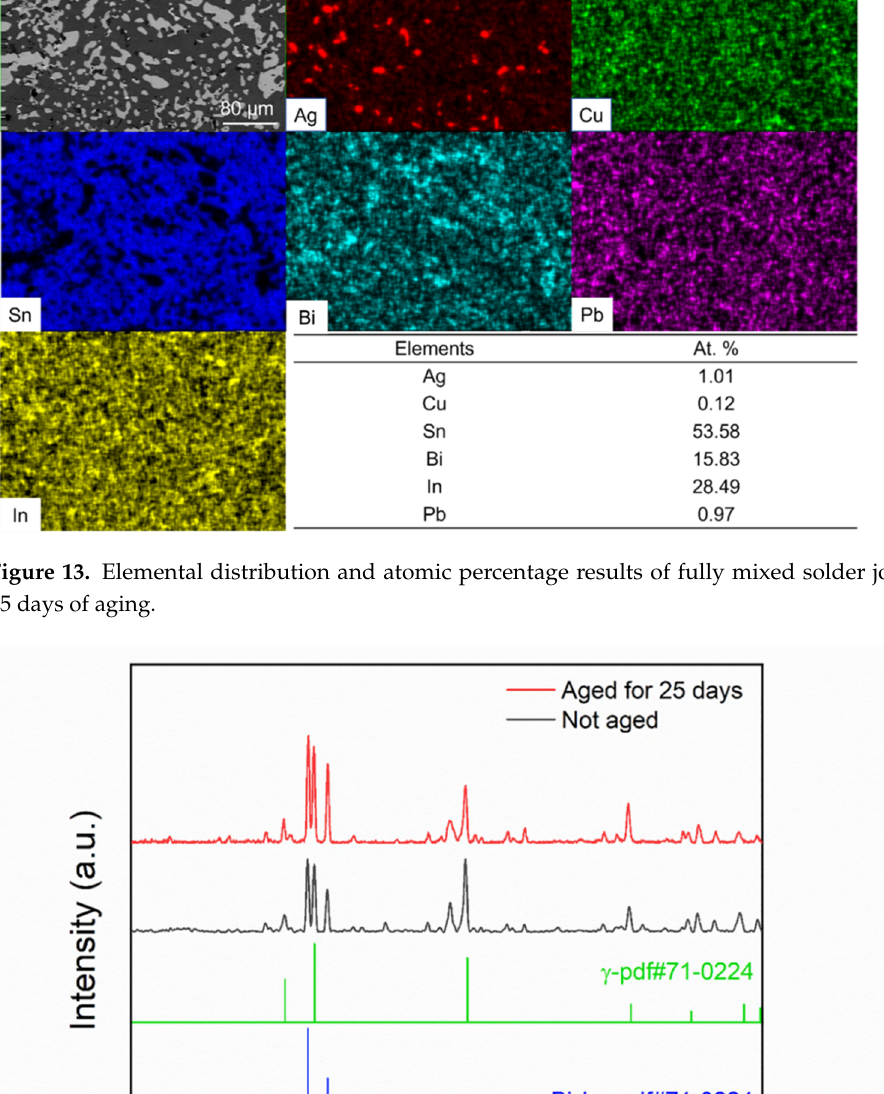
Figure 12. Composition analysis of IMC: ( a ) before aging and ( c ) after 25 days of aging: ( b ) EDS results of the region marked in ( a ); ( d ) EDS results of the region marked in ( c ).